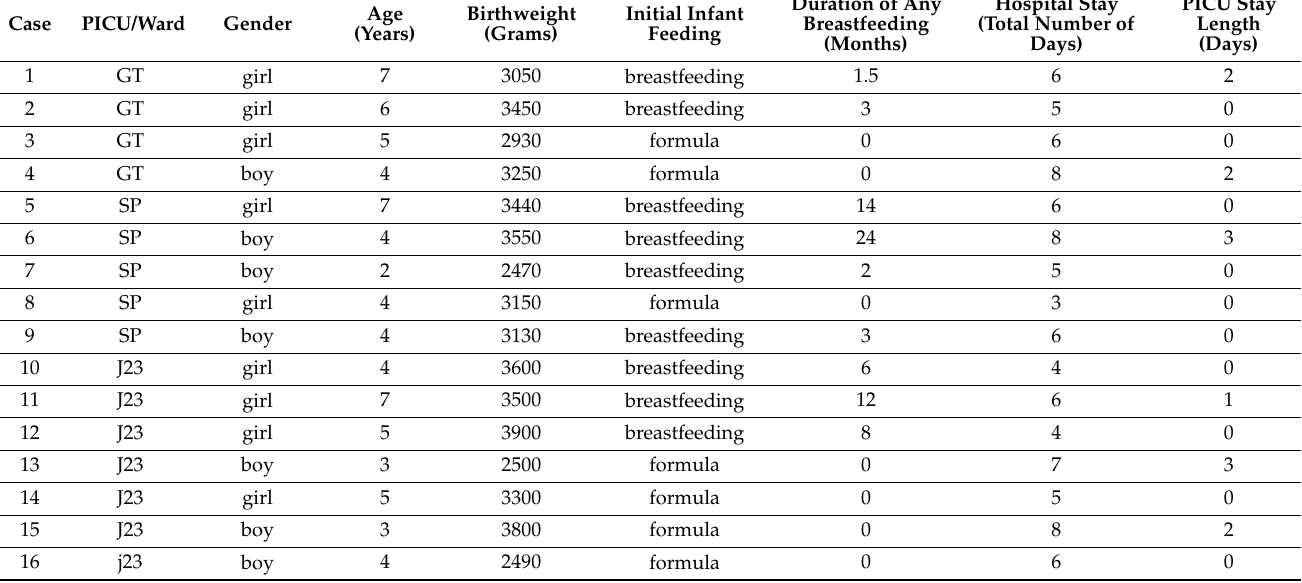
Table 1. General features of children with